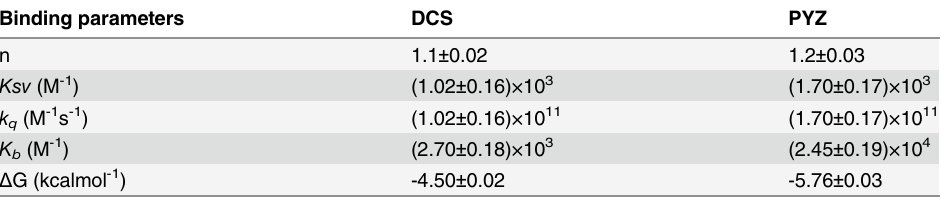
Table 3. Binding parameters obtained from steady state fluorescence measurements of both DCS and PYZ interaction with